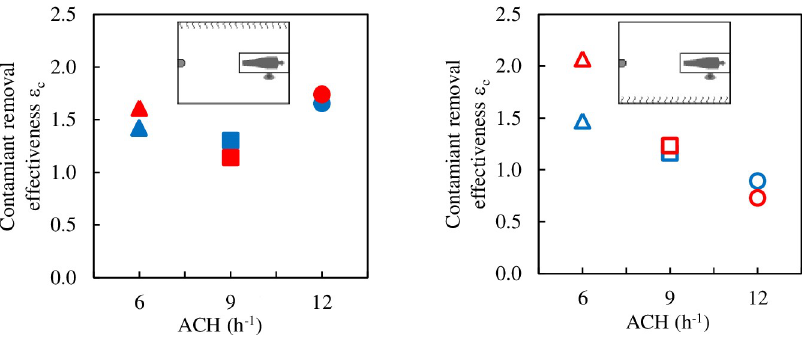
Fig 6. Contaminant removal effectiveness. Blue symbols: exhaust openings on the wall of the DD, red symbols: exhaust openings on the wall of the bed. Full symbols: radiant wall in front of the HCW. Empty symbols: radiant wall behind the